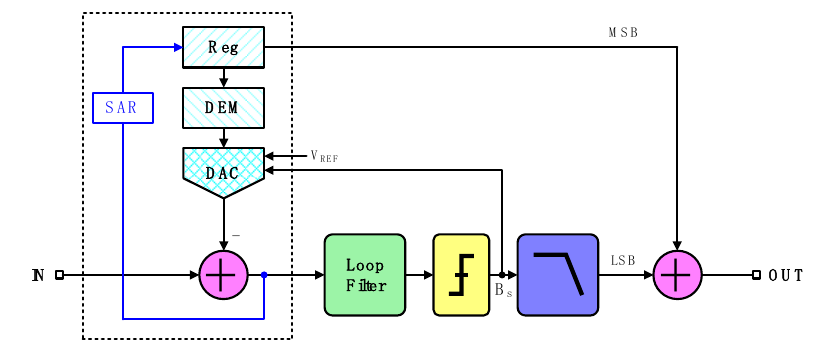
Figure 9. Block diagram of the employed zoom analog-to-digital converter (ADC).